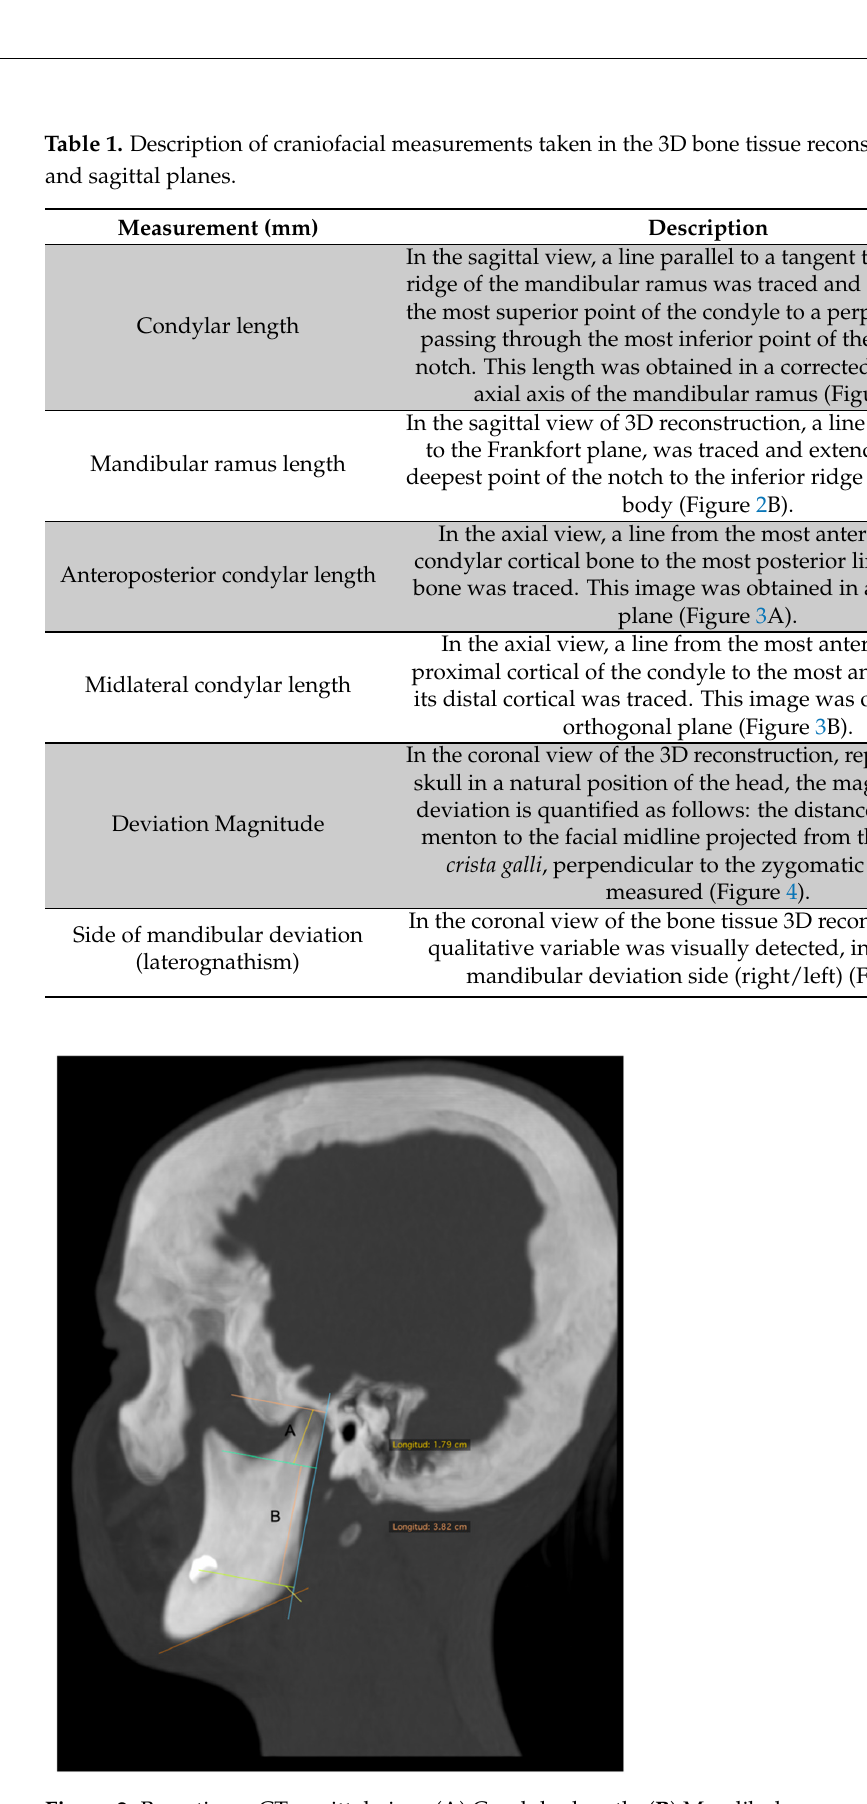
Figure 2. Bone tissue CT, sagittal view. ( A ) Condylar length. ( B ) Mandibular ramus length.